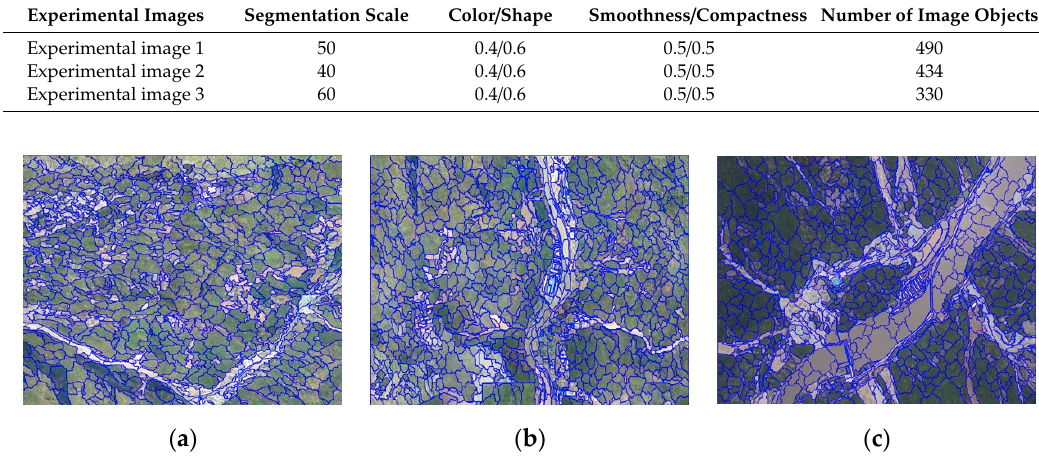
Table 2. Optimal image segmentation parameters.